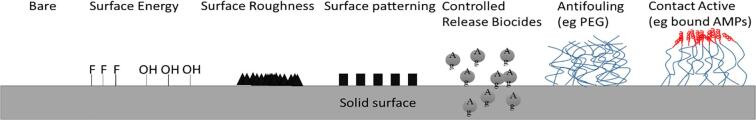
Examples of antibacterial and anti-biofilm surface solutions (Adlhart et al., 2018, Chen et al., 2013, Lozeau et al., 2015). These include chemical or physical modifications to alter surface energy, surface roughness, surface patterning, controlled release of biocides (such as silver), antifouling polymers, and contact-active surfaces (bound antimicrobial peptides (AMPs).